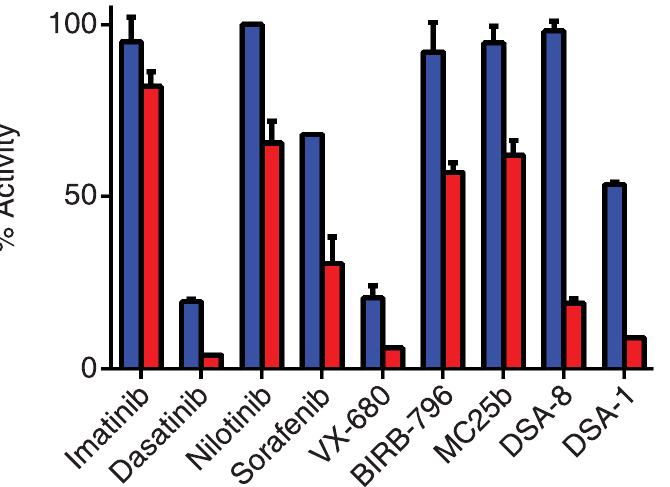
Fig 3. Effect of kinase inhibitors on MbAbl2. MbAbl2 activity was measured in the presence of 1 μ M and 20 μ M concentrations of the indicated inhibitors. Activity was measured using the phosphocellulose binding assay with Abl peptide substrate at a concentration of 125 μ M. The concentration of ATP was 200 μ M. Error bars show standard deviations.